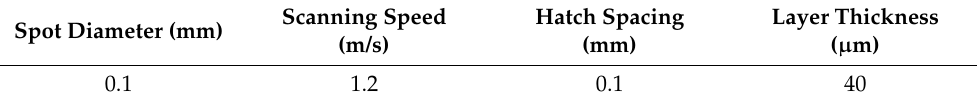
Table 1. Process parameters used for computational PBF-LB process modelling (data from [15]). Spot Diameter (mm)